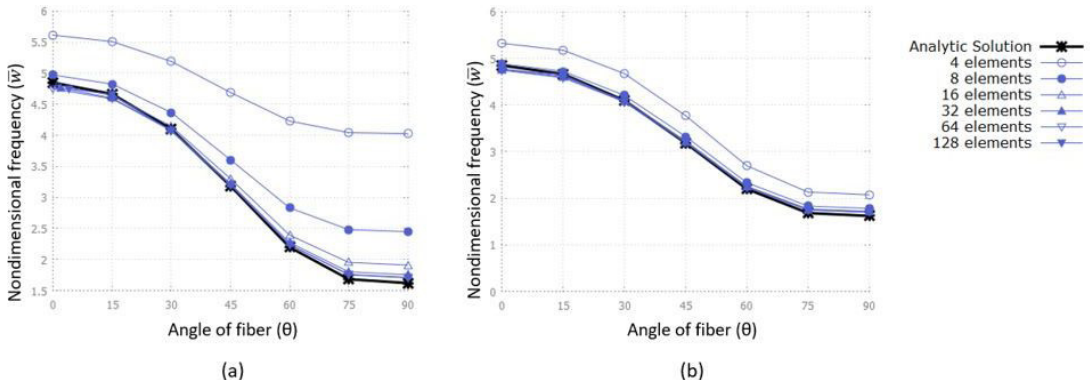
Figure 8. ( a ) First frequency for different ply fiber directions for the clamped-free (CC) beam computed using the parasitic shear finite element model; ( b ) First frequency for different ply fiber directions for the clamped-free (CC) beam computed using the corrected finite element